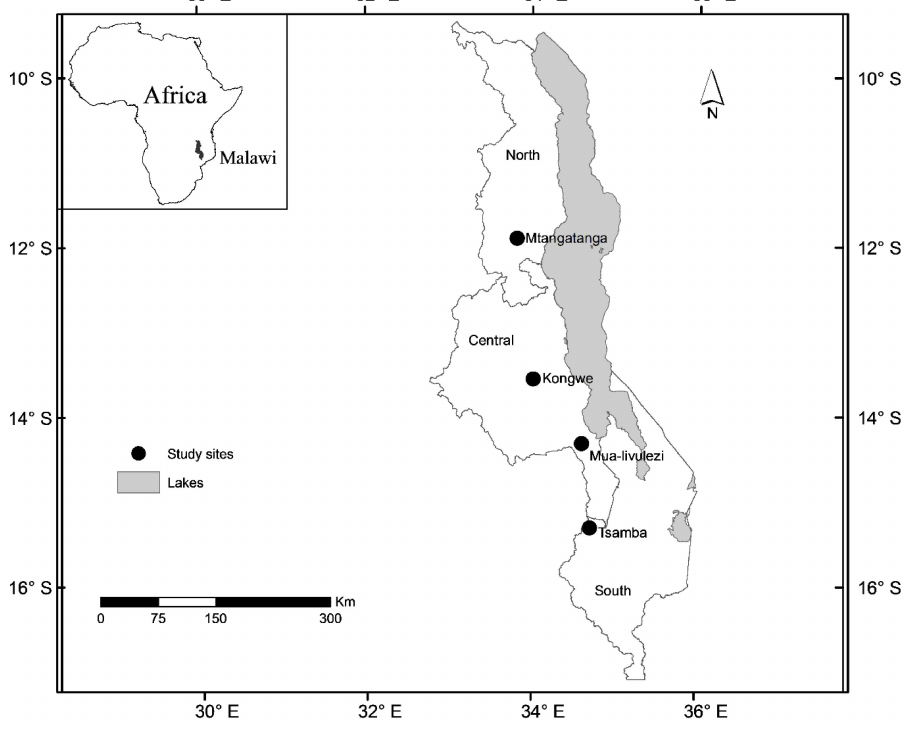
Figure 1. Map of Malawi showing the location of the study sites. Table 1. Geographical location, management regime, silvicultural classification and climatic conditions of study